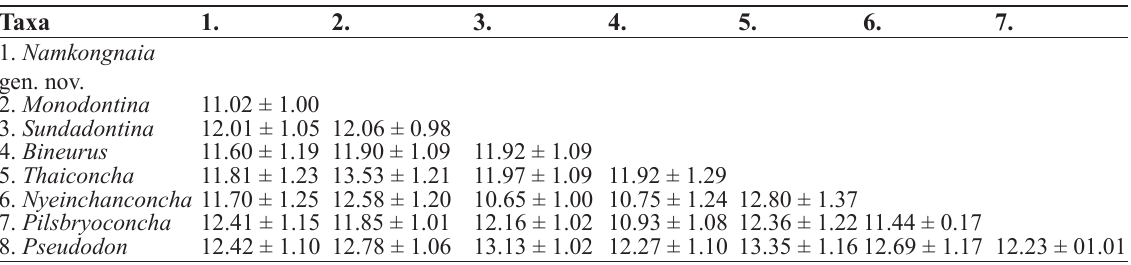
Table 2. Average genetic divergence based on uncorrected p-distance of 660-bp COI gene fragment sequences of freshwater mussel genera in the tribe Pseudodontini (% ±